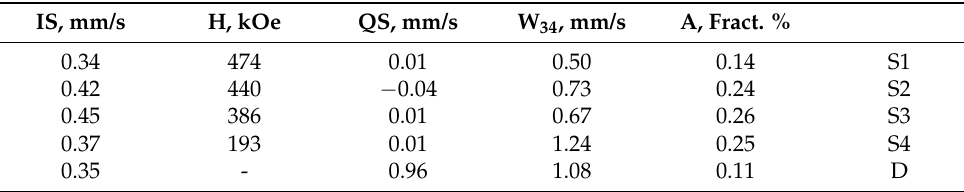
Figure 2. Mössbauer spectrum of starch-MNPs. Table 1. Parameters of the Mössbauer spectrum of